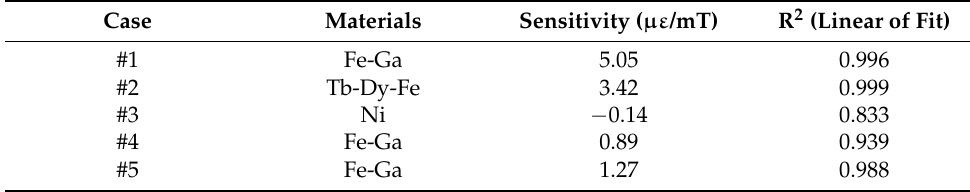
Table 2. Sensitivity of the